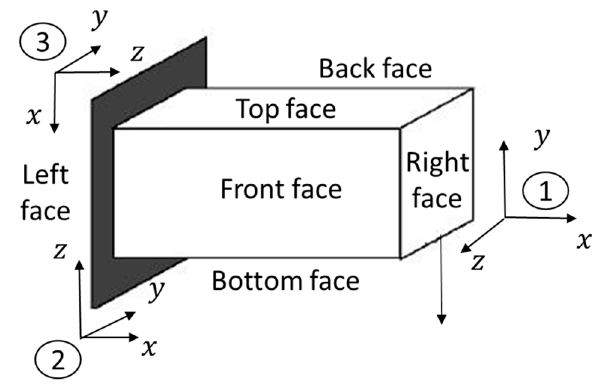
Figure 9. Cantilever beam with point load, printed in three different directions.